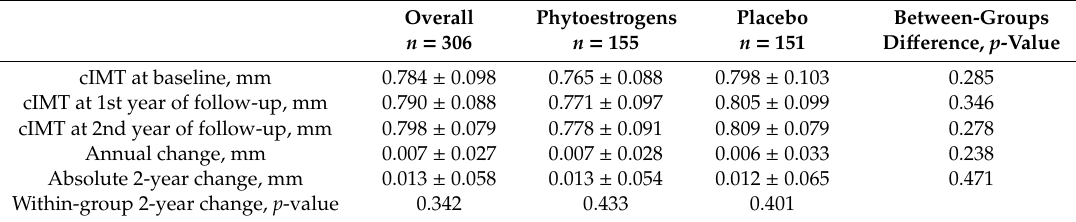
Table 3. Carotid intima media thickness (IMT) changes from baseline to 2-year follow-up visit in the early postmenopausal